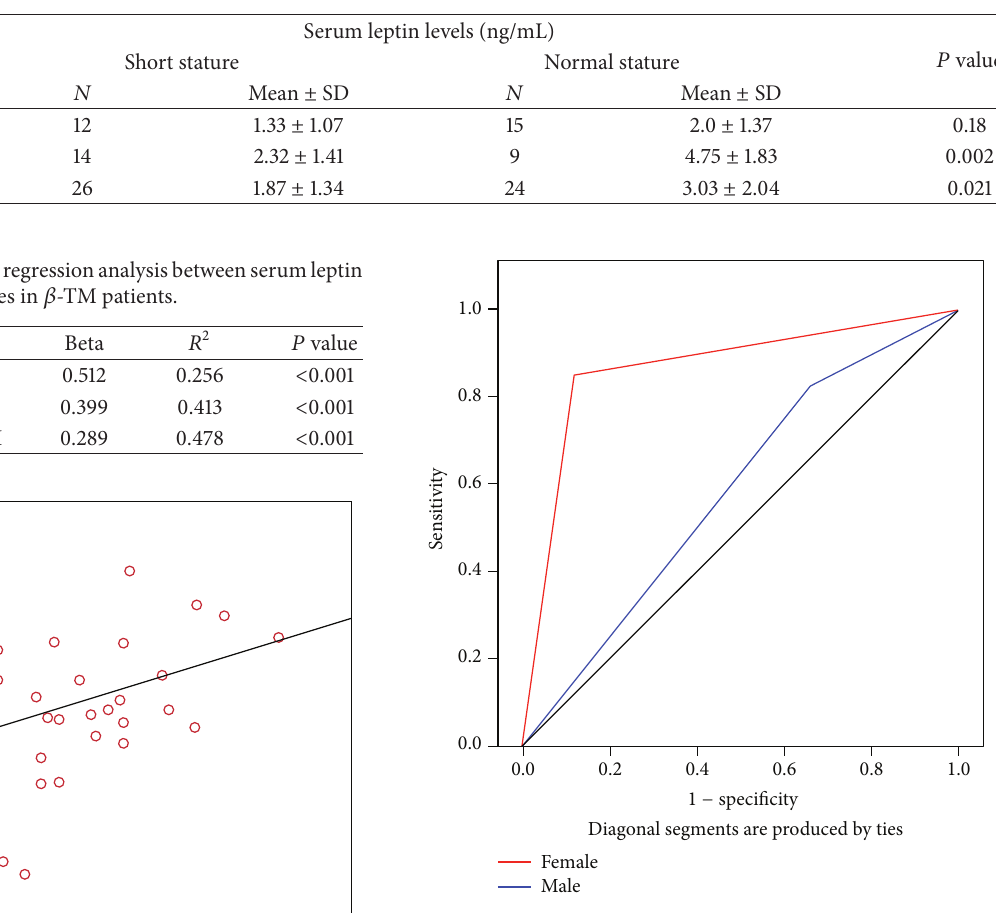
Table 3: Serum leptin levels in 𝛽 -TM patients with normal and short stature according to gender.